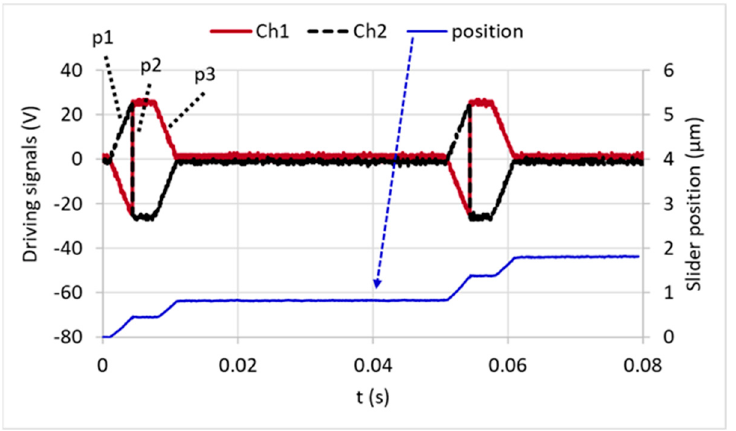
Figure 5. Single-step burst driving waveforms and the resulting slider position were measured for a slip time of 2 µs at 100 Hz.